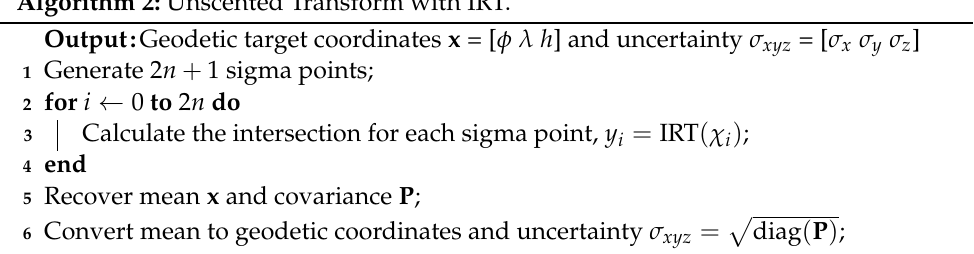
Algorithm 2: Unscented Transform with IRT.